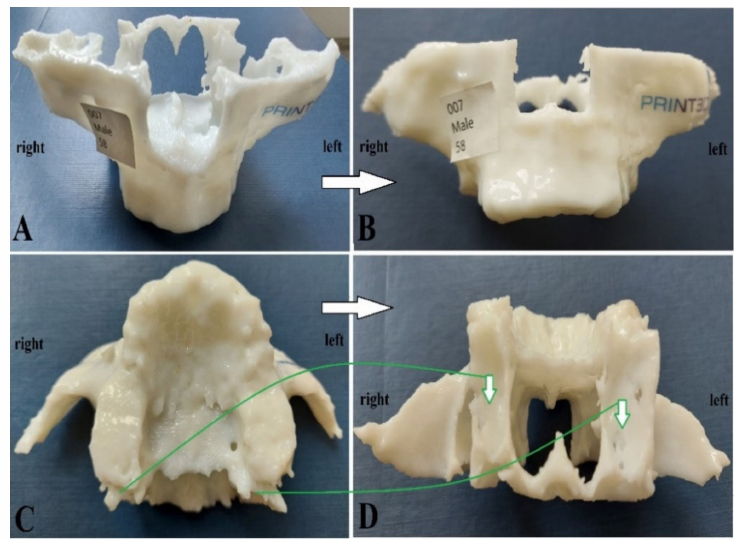
Figure 1. The example of the 3D printed model of maxilla of the 58-year-old male ( A – D ). ( A , B ) anterior aspect; ( C )—inferior aspect; ( D )—posterior aspect (arrows show the right area and left area of the posterior